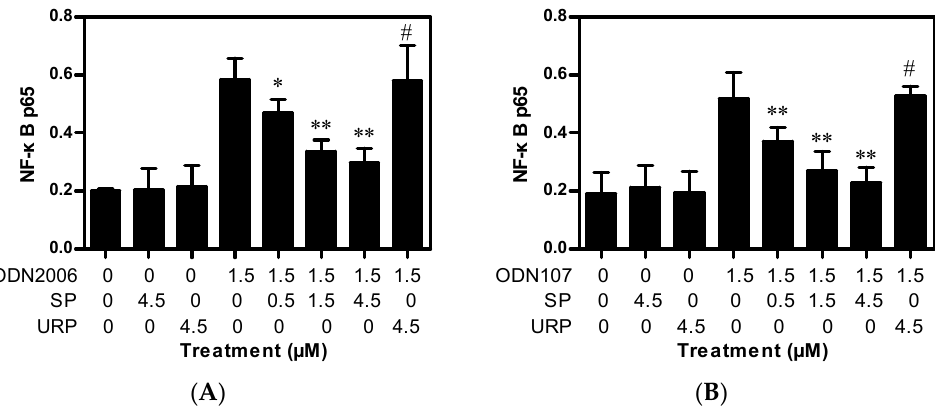
Figure 3. Synthetic peptide (SP) inhibited NF- κ B activation induced by CpG oligodeoxynucleotides (CpG ODN) in RAW264.7 cells. RAW264.7 cells (5.0 × 10 6 cells) grown in six-well plates were treated with 1.5 μ M of ODN2006 ( A ) or ODN107 ( B ) preincubated with SP (0, 0.5, 1.5, or 4.5 μ M) or unrelated peptide (URP) (4.5 μ M) at 37 °C for 15 min. After incubation for 4 h, the cells were collected to extract nuclear proteins. The p65 subunit was detected using enzyme-linked immunosorbent assay (ELISA) kits. Data from one of three independent experiments are shown ( n = 3). “ * ”, p < 0.05 vs. ODN2006 or ODN107; “ ** ”, p < 0.01 vs. ODN2006 or ODN107; “#”, p > 0.05 vs. ODN2006 or ODN107.